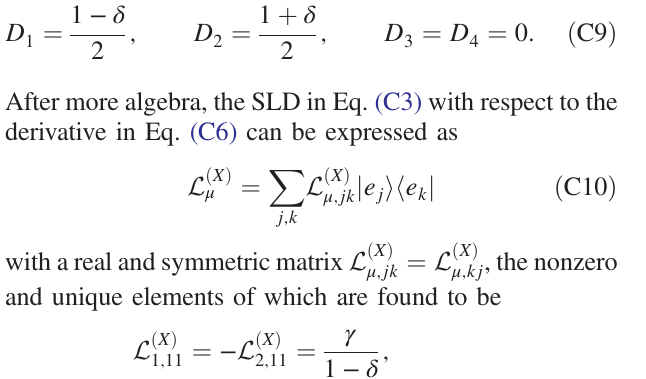
ˇ θ 1 to align SPADE